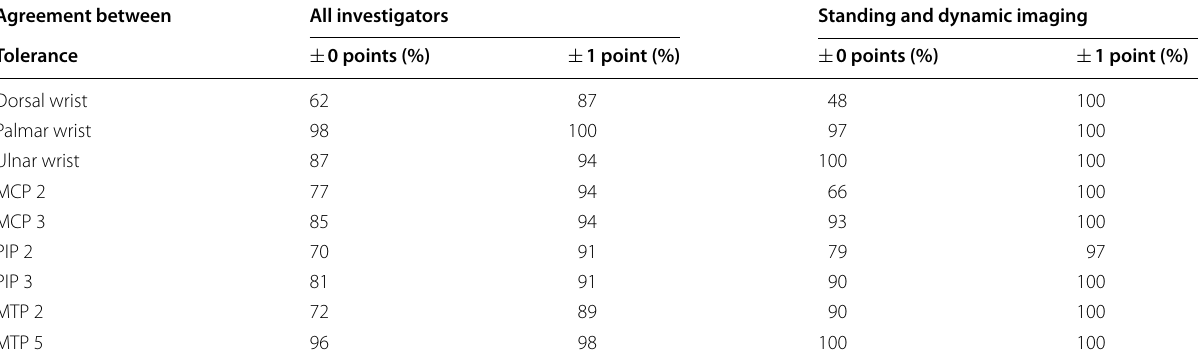
Agreement between all investigates for inflammatory signs according to the ‘US7 Score’ as well as between standing images (post hoc evaluation by specialists) and dynamic assessment (by the trained medical student). Results are presented with a permitted deviation of one point and without permitting a deviation